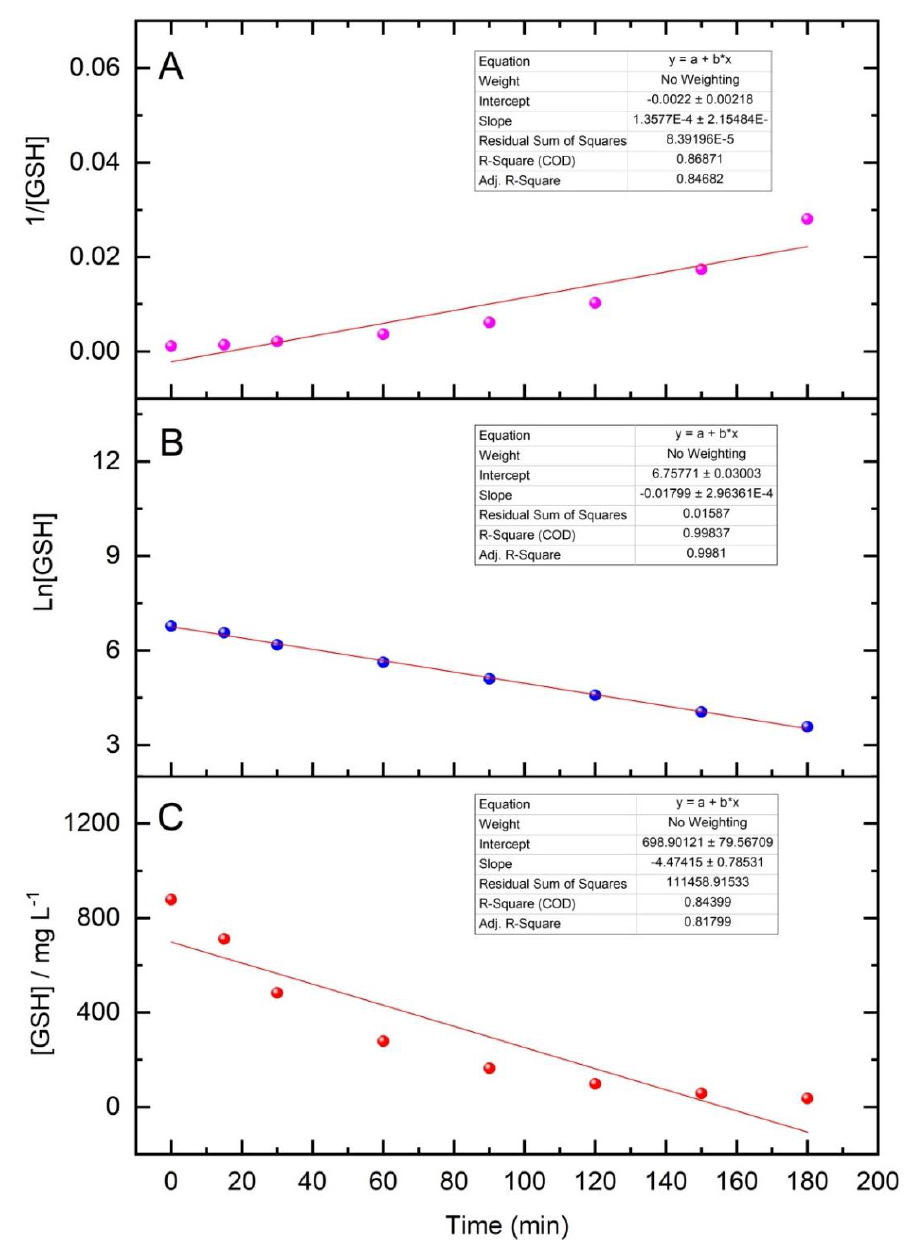
Figure 5. Kinetic models of the oxidative degradation of GSH by HPLC; ( A ) zero order, ( B ) first order and ( C ) second order.